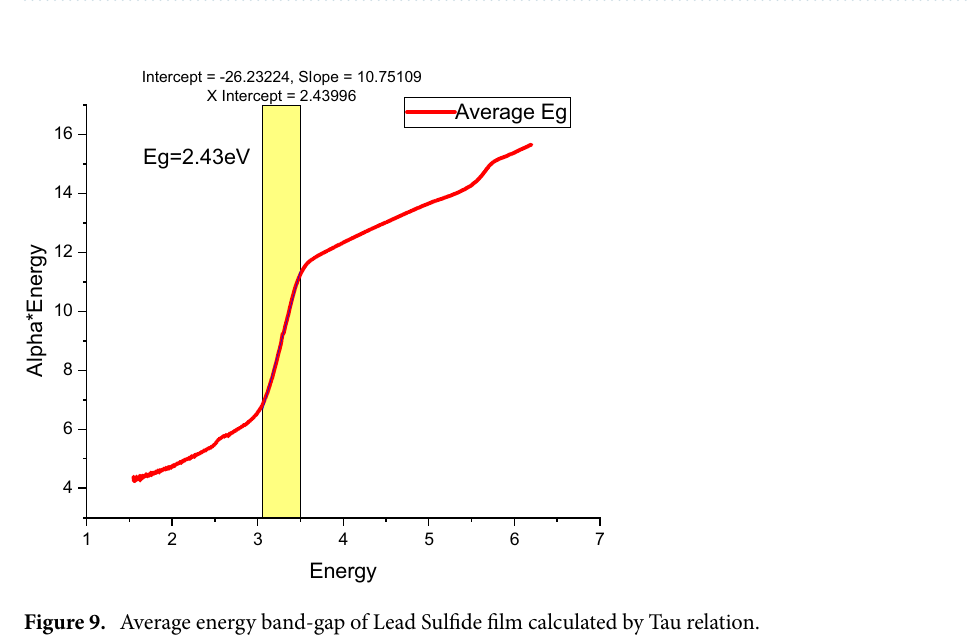
Figure 8. UV–Vis spectral of Lead Sulfide thin films from Avocado ( Glycosmis cochinchinensis ) Leaf extract at different pH values varied as ( a ) 2, ( b ) 4, ( c ) 6 and ( d ) 8.